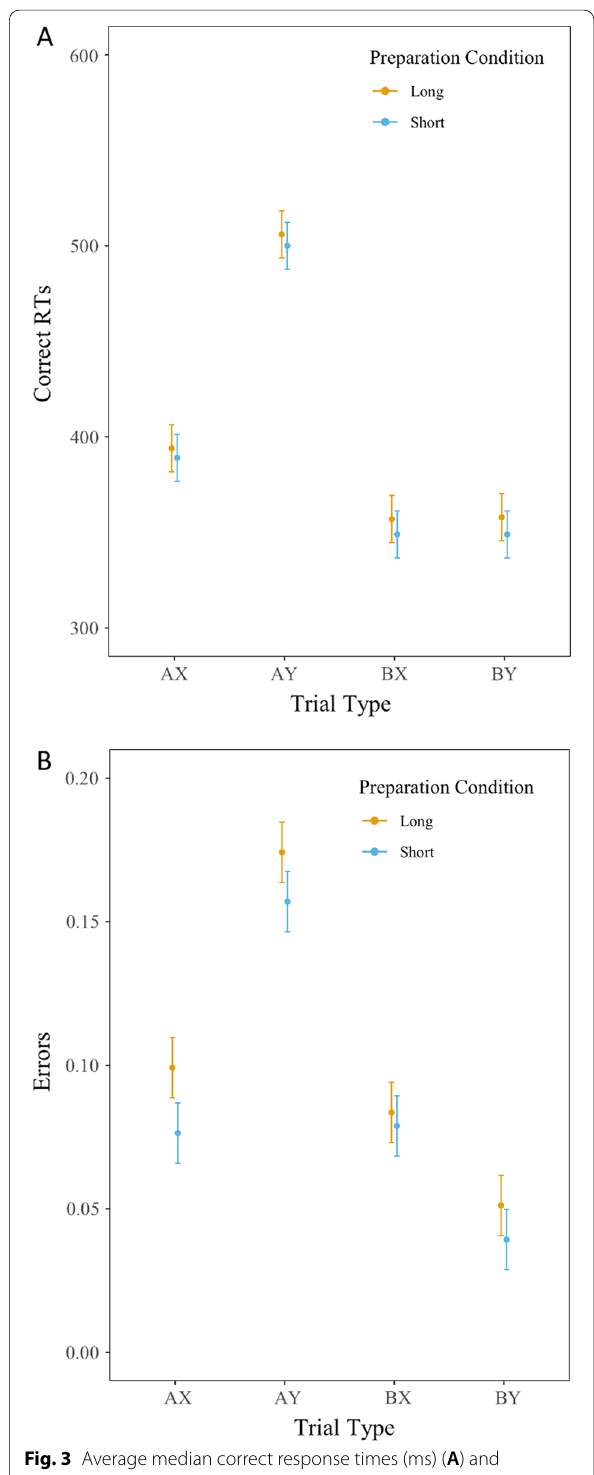
Fig. 3 Average median correct response times (ms) ( A ) and error rates ( B ) in the AX-CPT as a function of AX-CPT trial type and preparation condition (long or short) in the Pilot Study. Error bars standard error of the mean (SEM) =